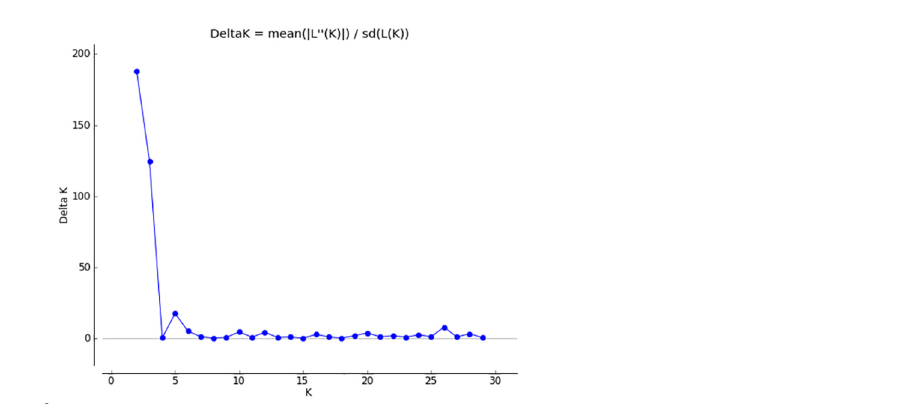
Fig 1. STRUCTURE HARVESTER results for downy mildew showing a K value of 5.